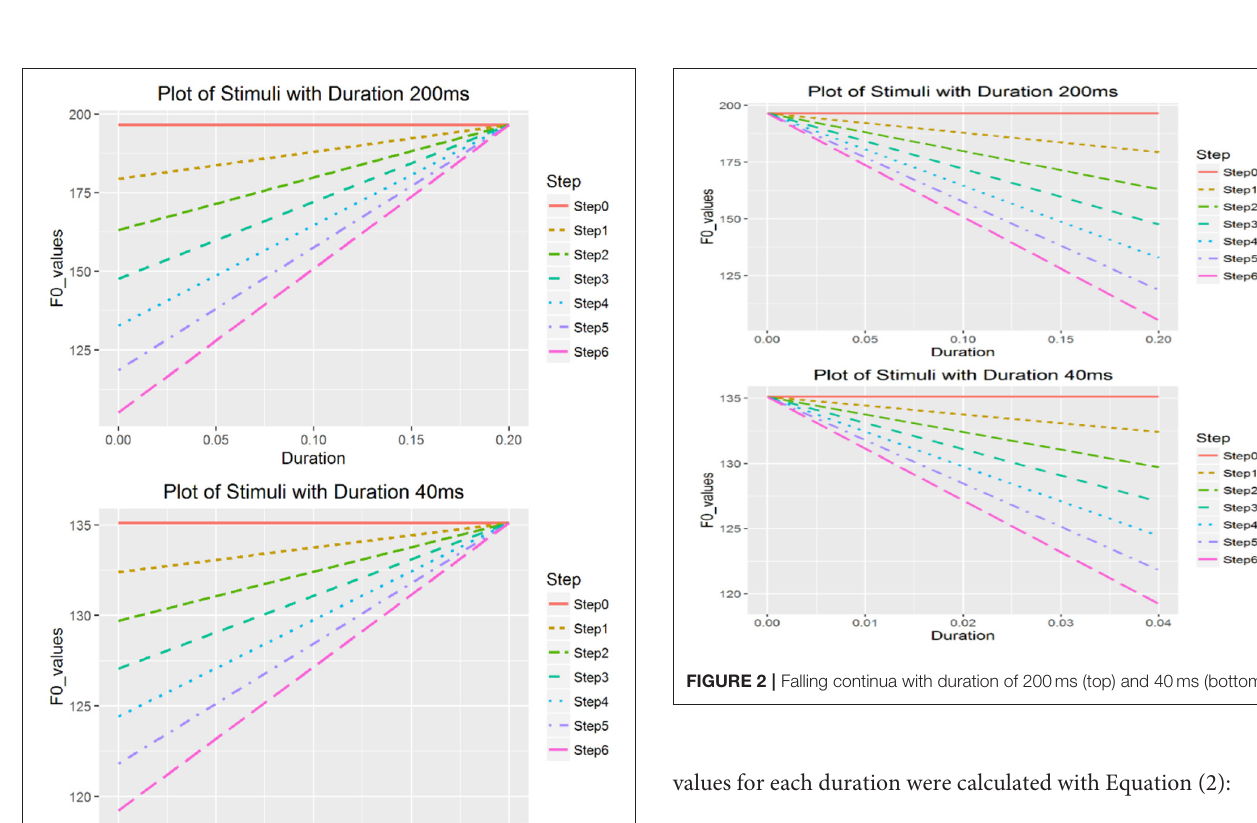
values for each duration were calculated with Equation (2): X ( t ) = 93.4 ∗ t − 2.2 (2) where t is the duration in s, and X( t ) stands for the semitone (st)-values at the offset of the tone. For example, for the 200